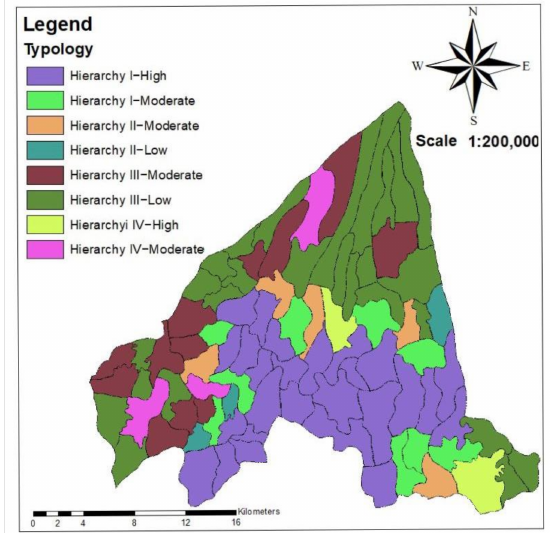
Figure 4. Village typology map based on socio-economic vulnerability level (Source: Results of secondary data processing,